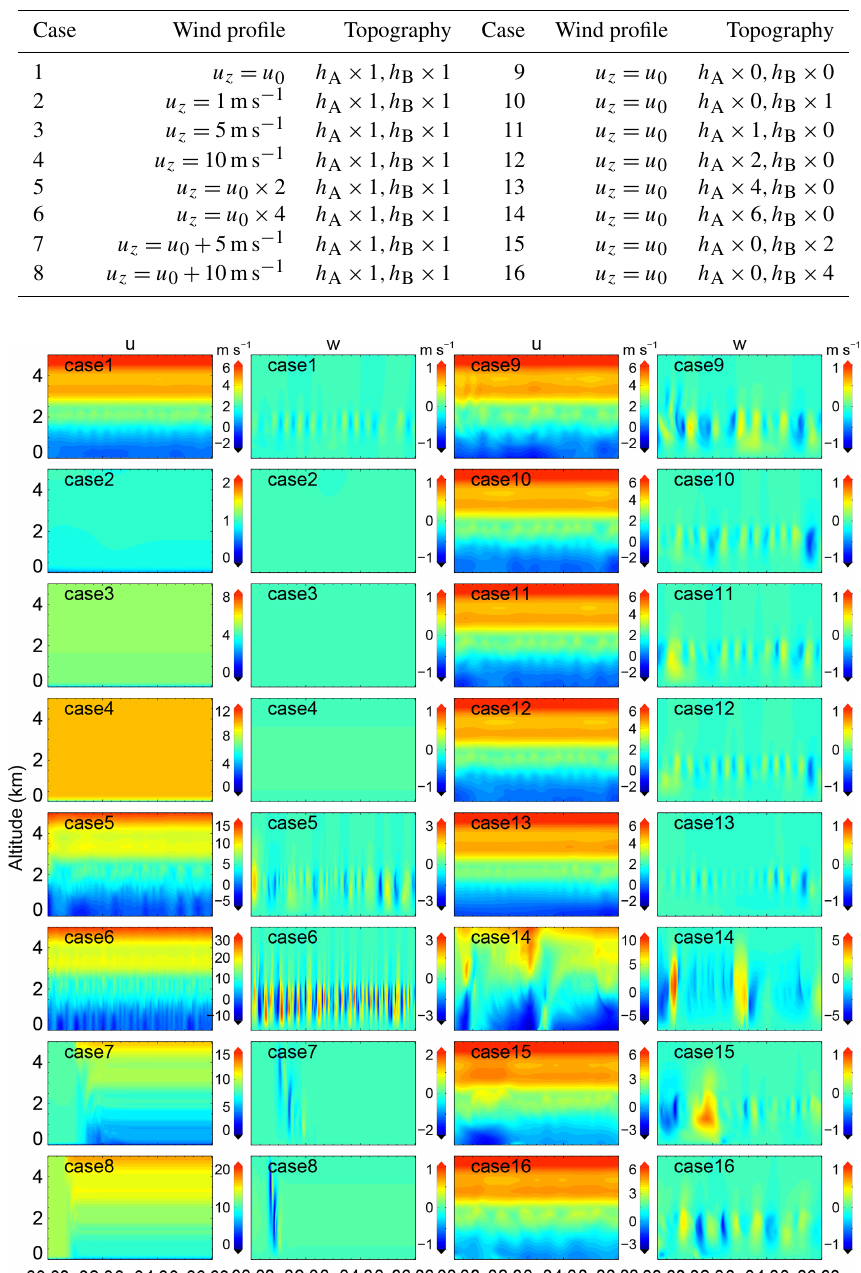
Figure 8. The simulated zonal wind u and vertical wind w above the lidar for all 16 cases as described in Table 2.